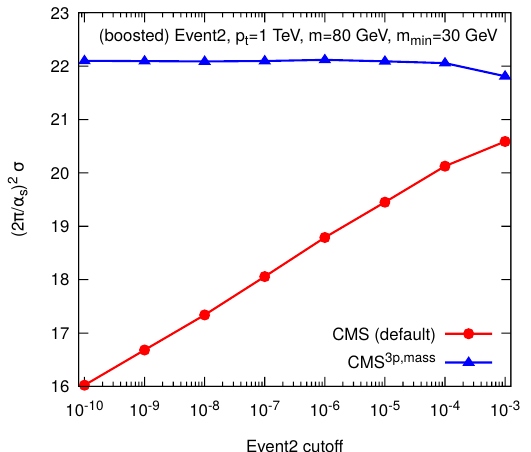
Figure 12. Cross-section for passing the CMS tagger as a function of the Event2